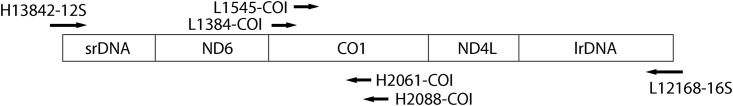
A portion of the mitochondrial genome amplified in the present study.Primers used for the amplification were indicated as arrows. Refer to the text for the primer sequences.